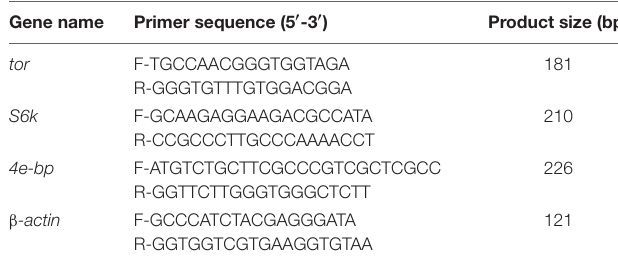
TABLE 5 | Primers used for real-time quantitative